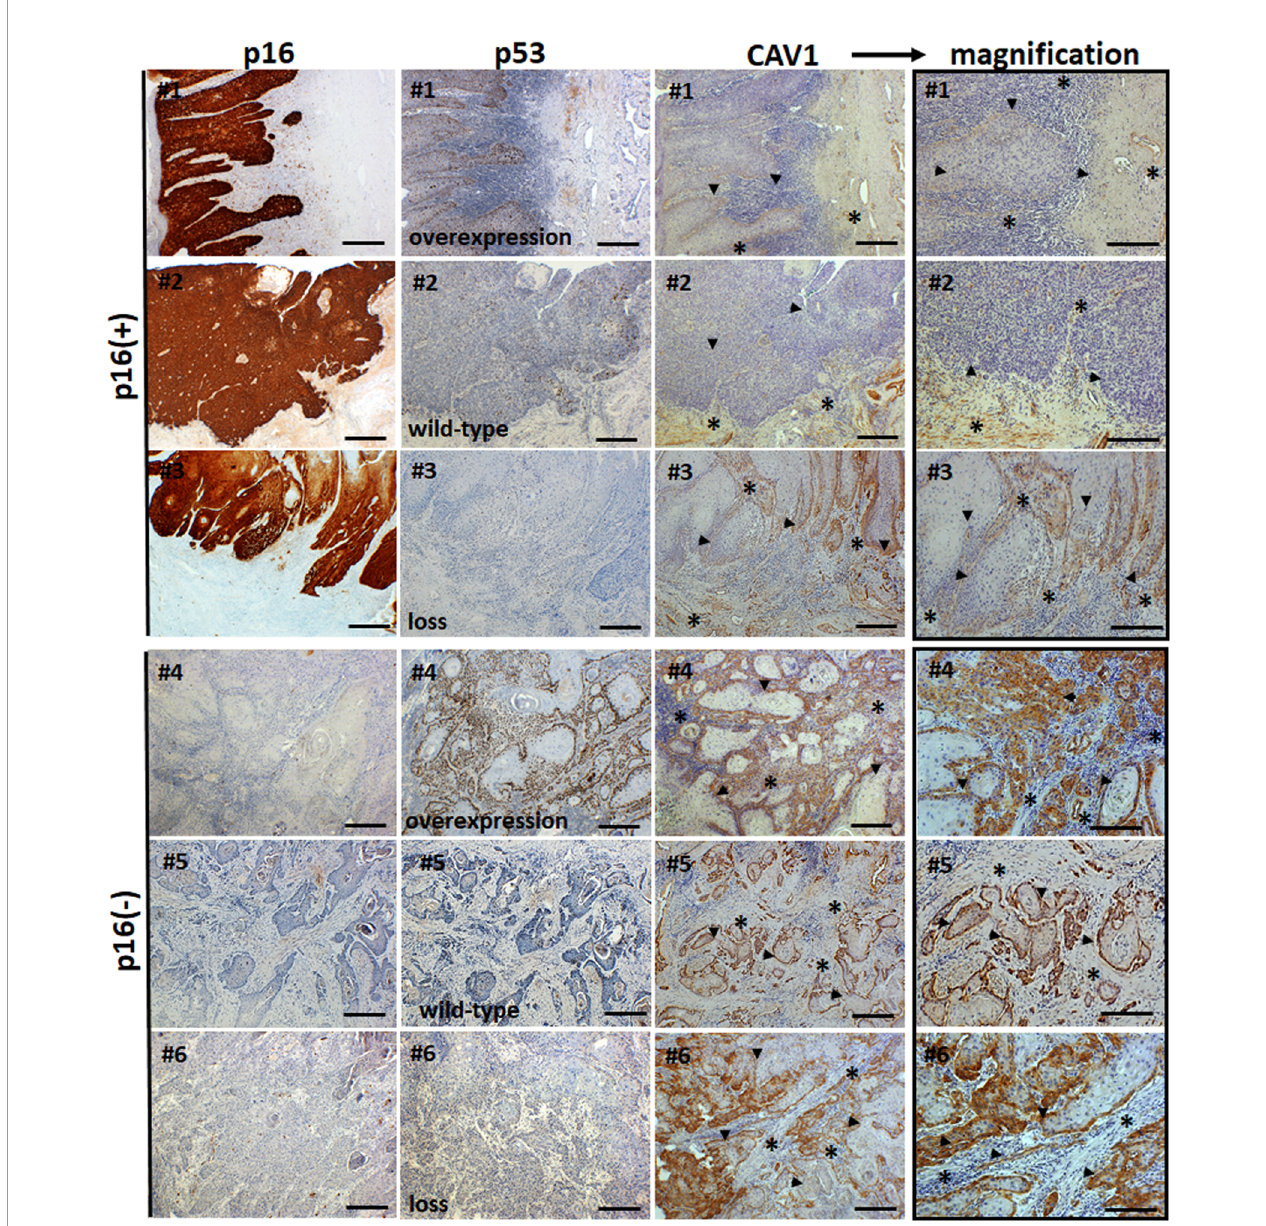
FIGURE 1 | Immunohistological analysis of CAV1 levels and epithelial-stromal CAV1 distributions in correlation with p16 and p53 levels in human penile tumor tissues. Paraf fi n-sections of human penile carcinomas were stained for p16, p53 and CAV1 in combination with DAB (brown). Representative images of p16-positive [p16(+)] and p16-negative [p16(-)] tumor specimen are shown. The 53 status (overexpression, wild-type and loss) is indicated. Asteriks (*) mark stromal compartments and bold arrows point to epithelial structures. Sections were counterstained using hematoxylin. # indicates different patients. Scale bar: 200 µm, scale bar of higher magni fi cation images (CAV1): 75